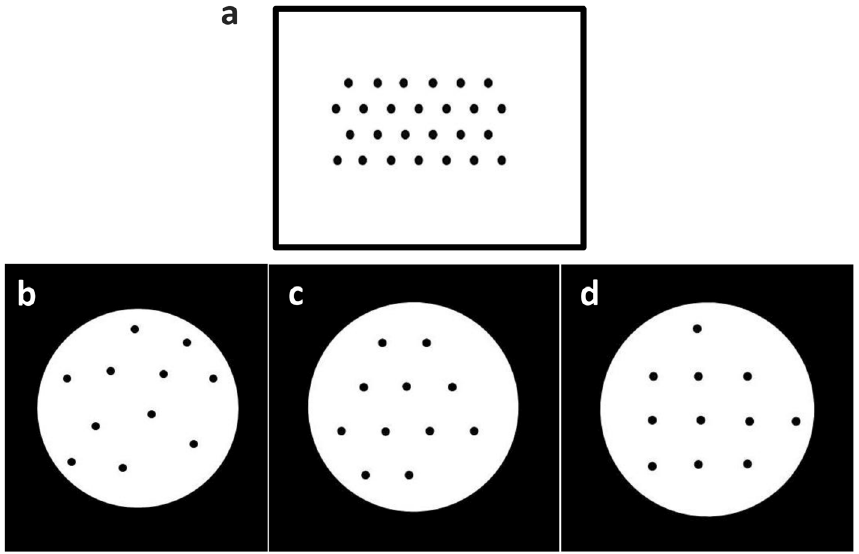
Figure 1. ( a ) Sample of an arrangement without proximity and similarity effect. ( b ) irregular arrangement, ( c ) hexagonal arrangement, and ( d ) quadrangular arrangement for number